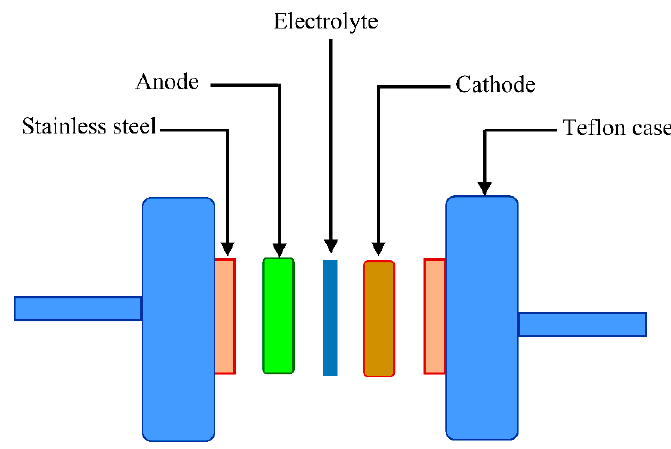
Figure 8. Schematic presentation of the fabricated electric double layer capacitor (EDLC) cell.